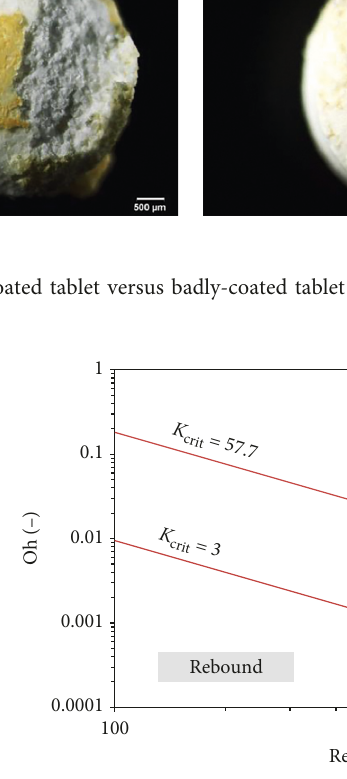
Figure 6: Impact mechanism diagram [26] of experiments A–E.